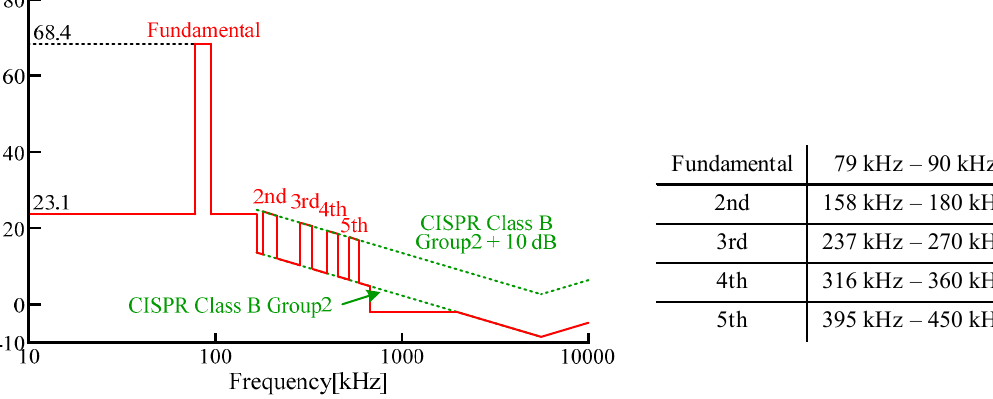
Figure 1. Maximum allowable radiation noise for inductive power transfer (IPT) system of 7 kW or less for use in electric vehicles (EVs) in Japan (under discussion).